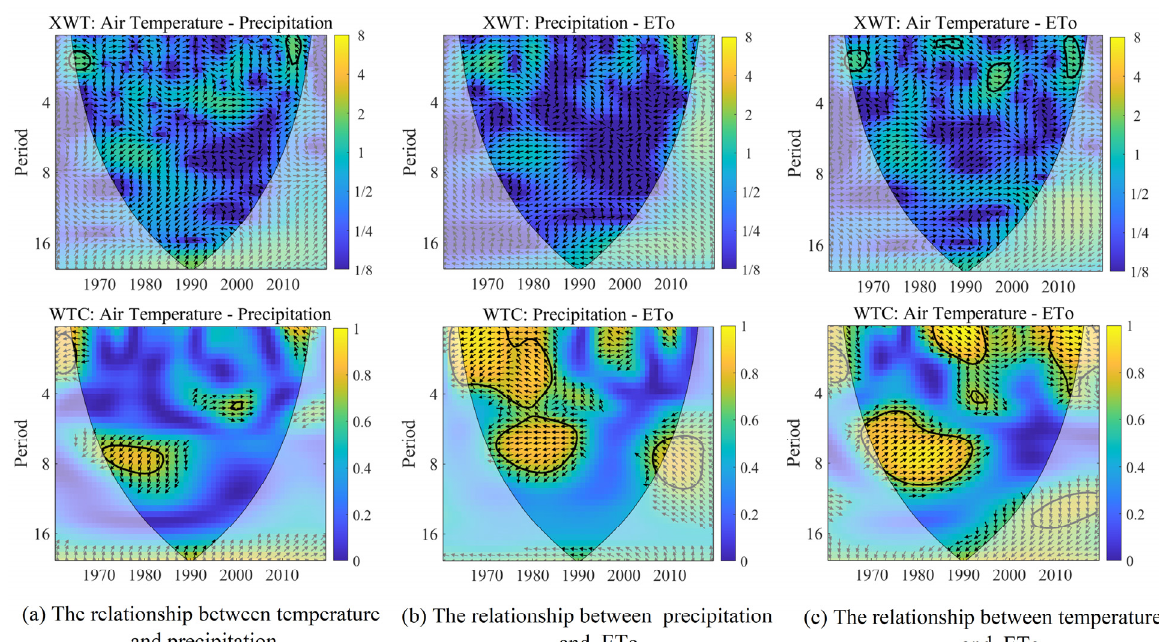
Figure 5. Cross Wavelet Transform of AT, precipitation, and ETo. Note: The region surrounded by the influence cone is the effective spectrum value, the remaining regions represent the invalid spectrum value, and the region surrounded by the thick line indicates that it has passed the test of the red noise standard spectrum at the 0.05 significant level. The arrow shows the phase relationship between the two, the right (left) arrow denotes a positive (negative) correlation, the up (down) arrow denotes a phase difference of 90 ◦ , and the timing is advanced (delayed) by 1/4 period. After fi ltering the in fl uence of ETo on rainfall (Figure 6), the annual correlation curve between AT-precipitation removes the negative correlation characteristics. The correlation results were centered around 0.7, indicating a positive correlation. This is consistent with the arrow pointing to the right trend of AT precipitation on the fi ve-year time scale in the WTC, suggesting that the LRCC in this study is reasonable. It is worth noting that before the abrupt change (1962–1967), there was a high negative correlation between AT-precip- itation.